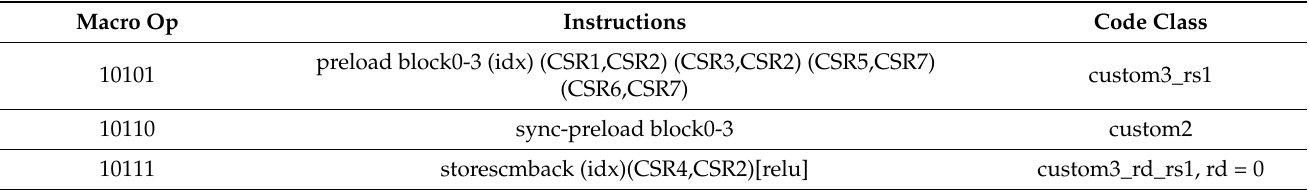
Table 5. The memory access instructions